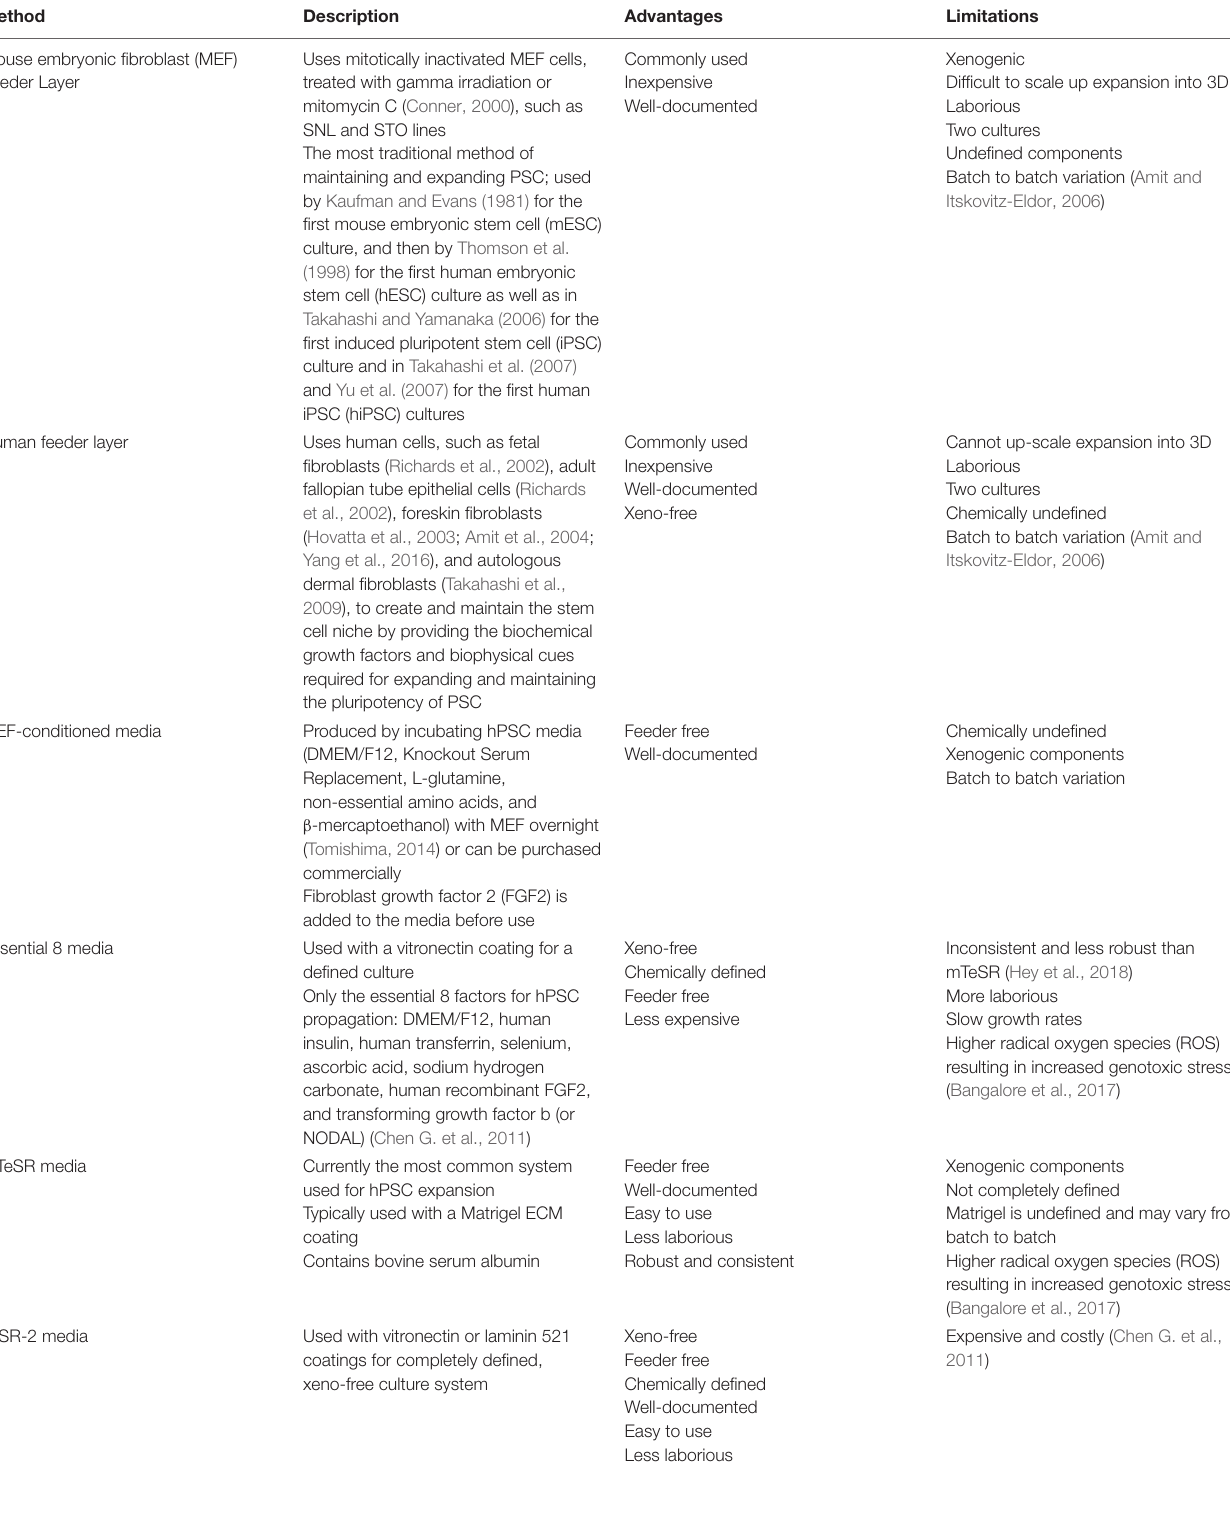
TABLE 1 | A summary of conventional methods of PSC expansion with their advantages and